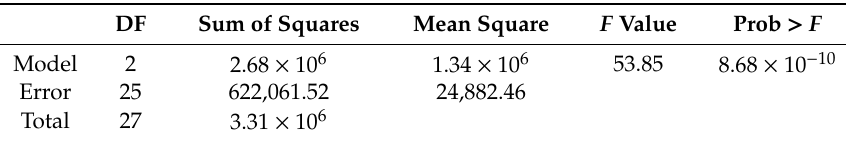
Table 4. Analysis of variance for Total Heat Release.